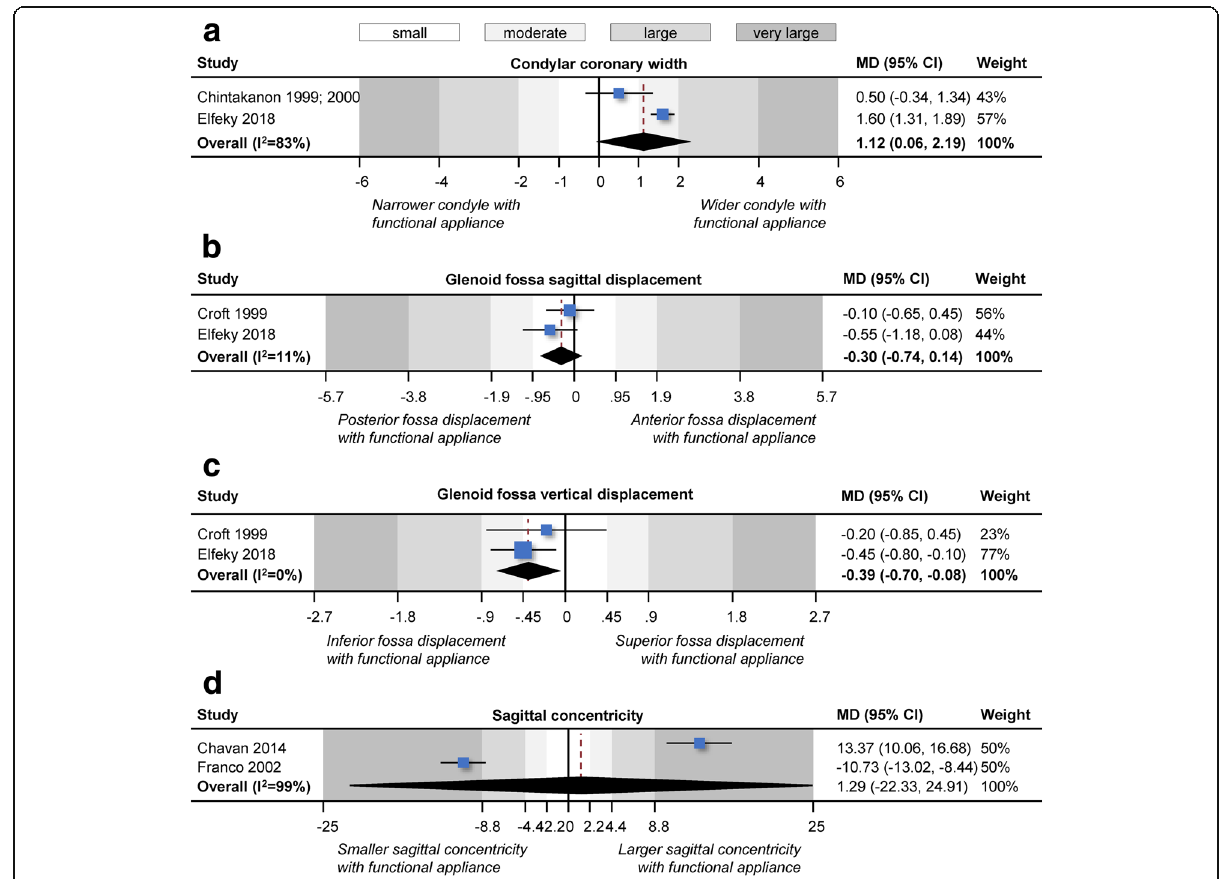
Fig. 4 Contour-enhanced forest plots for random effects meta-analyses comparing functional appliance treatment to no treatment (observation) in terms of changes in a condylar coronary width, b glenoid fossa sagittal displacement, c glenoid fossa vertical displacement, and d sagittal concentricity. CI, confidence interval; MD, mean